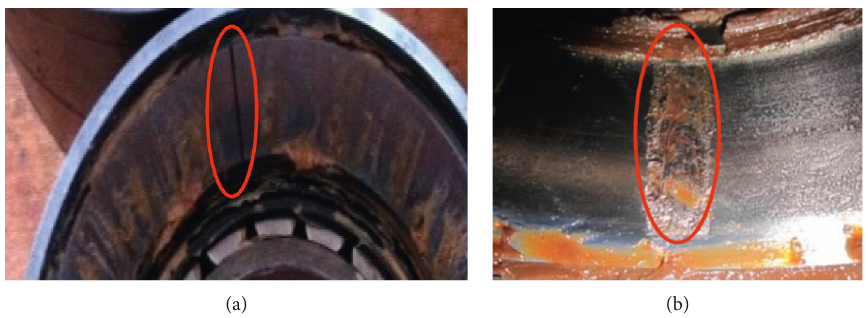
Figure 22: Photo of the faults (a) on the outer race and (b) on the inner race.